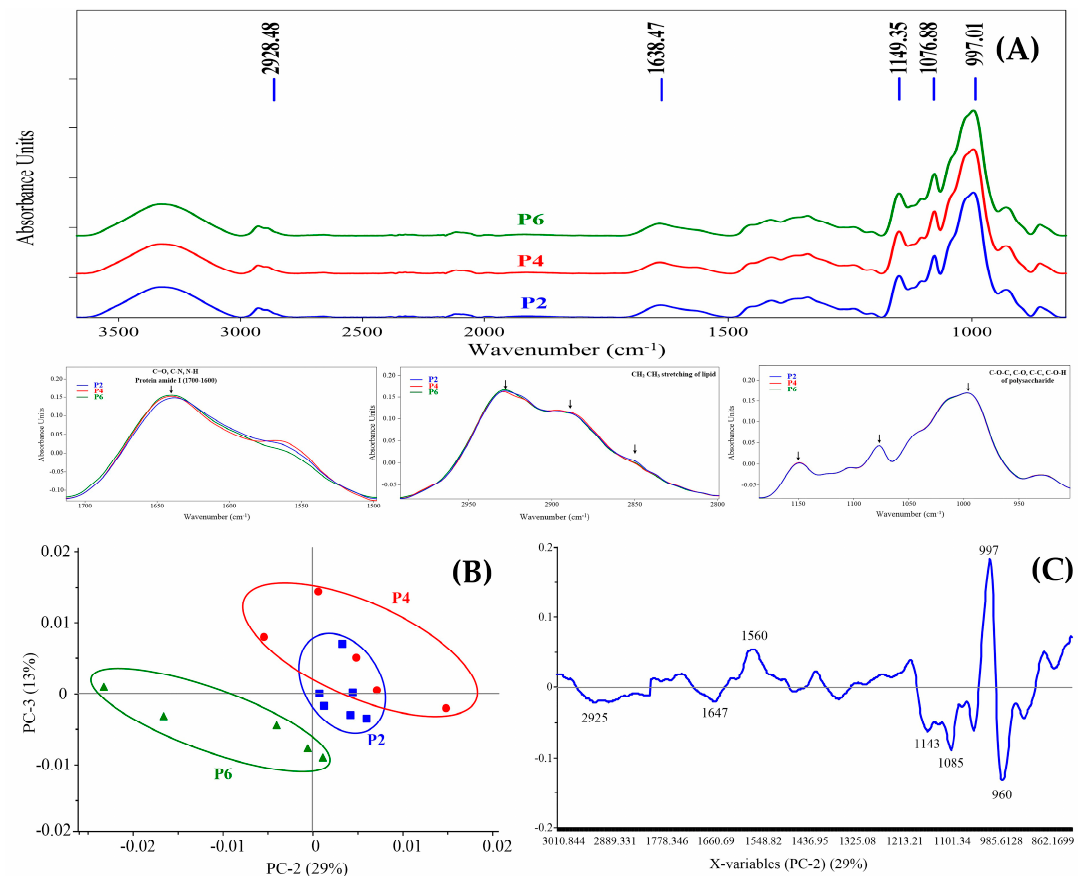
Figure 1. Comparison of three varieties of cassava flour by FTIR technique ( A ) average absorbance spectra ( B ) PCA analysis ( C ) loading plot.